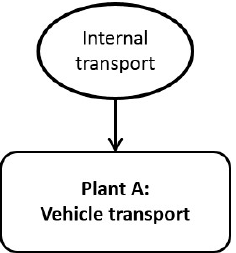
Figure 8. The connection between the sub-process vehicle transports and unit processes at biogas plant A.